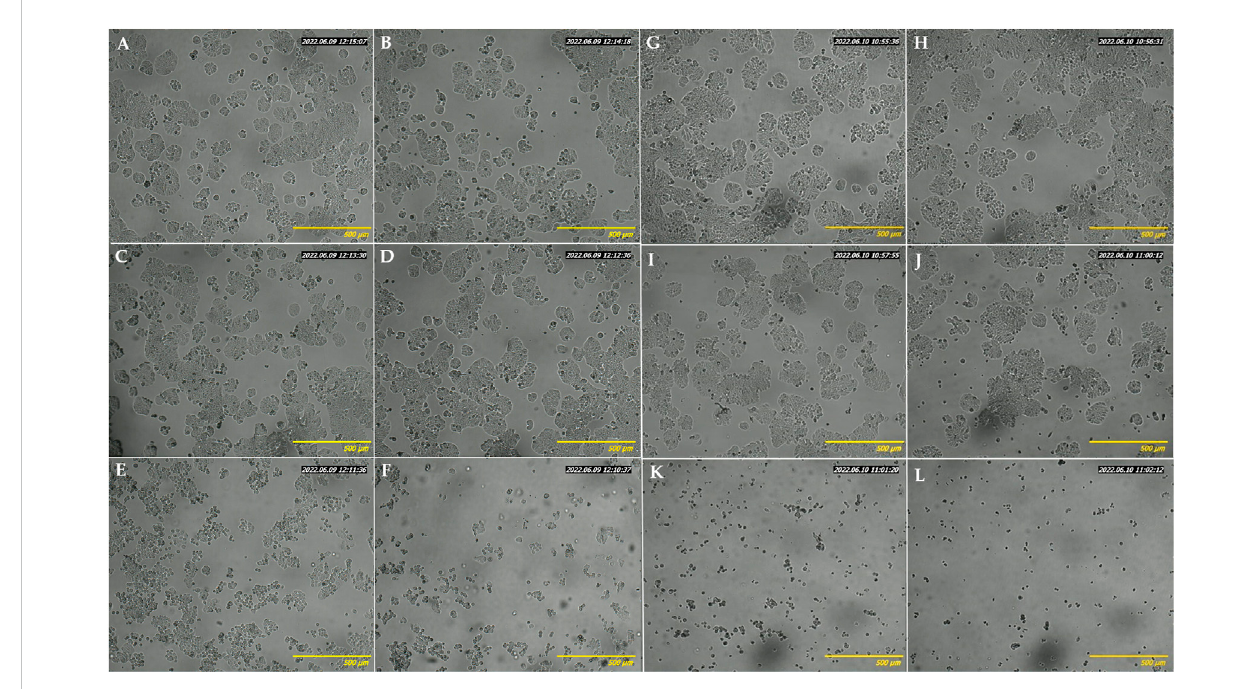
FIGURE 9 OpticalmicroscopyimagesofHT-29cellsafter 48 h (A – F) and72 h (G – L) incubationwithmedium (A,G) ,emptyBC (B,H) ,BC-0.25%EAE (C,I) ,BC- 0.5%EAE (D, J) , BC-1%EAE (E, K) , BC-2.5%EAE (F, L)